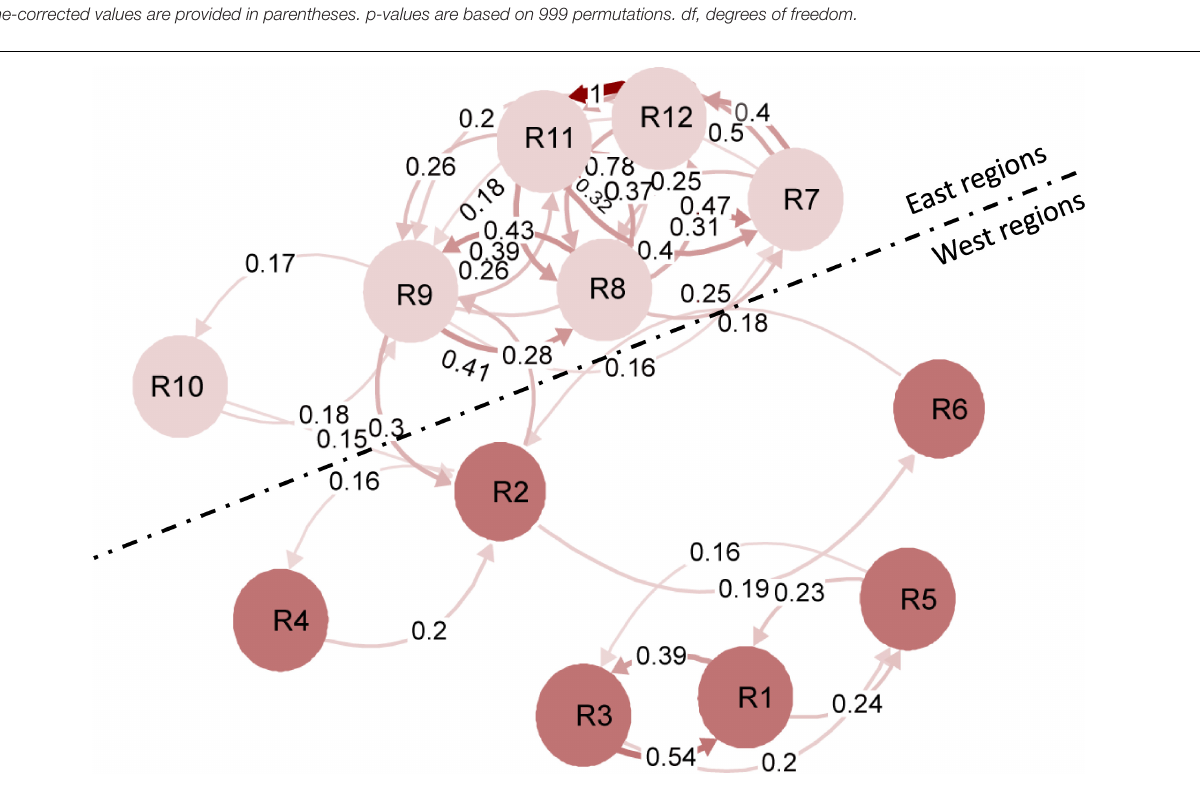
FIGURE 2 | Simplified migration networks to visualize the gene flow patterns of Puccinia striiformis f. sp. tritici among the 12 regional populations in the United States. Regions are represented by the nodes, and the gene flow strength is represented by the line thickness. The filter threshold was set to